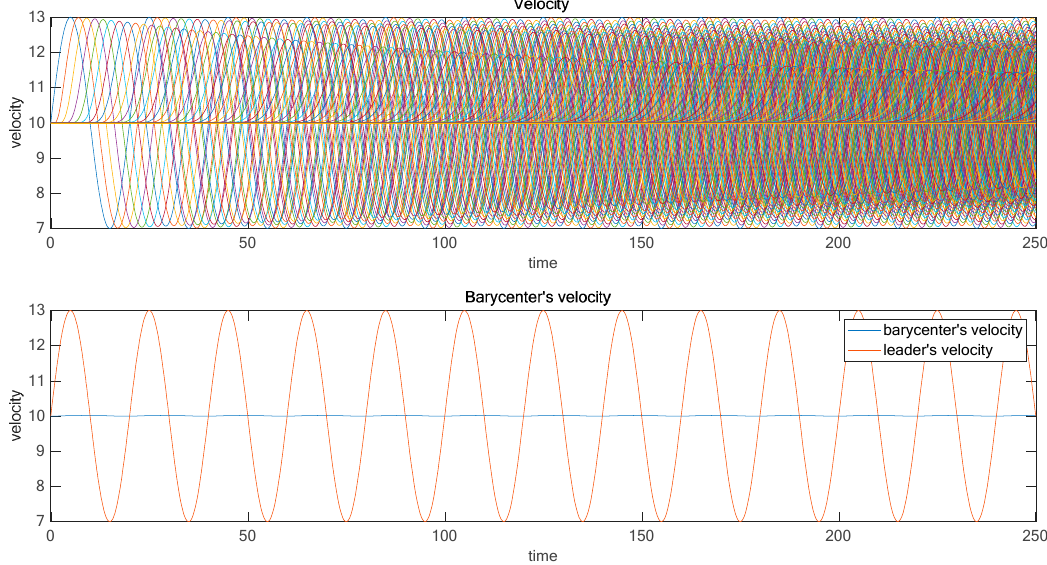
Figure 13. The standard model simulated with b = 20 m and excited by the harmonic perturbation of the Leader’s velocity Equation (14); symbolism is the same in Figure 9.